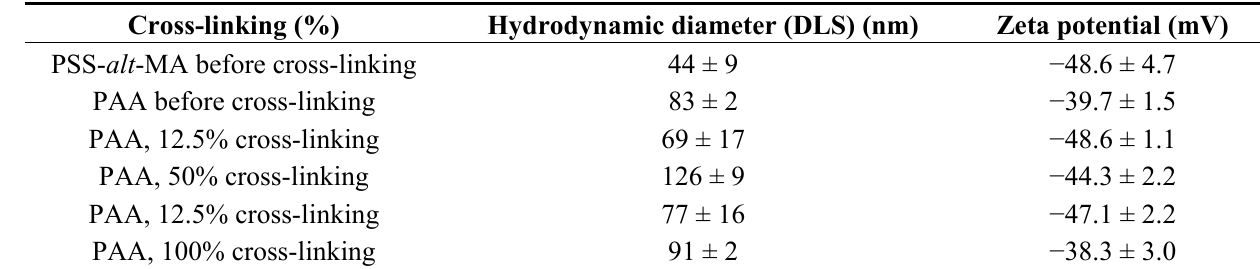
Table 3. Zeta potential and average hydrodynamic diameters of poly(acrylic acid) (PAA) or poly(styrene sulfonate- alt -maleic acid) (PSS- alt -MA)-coated IONPs with different cross-linking densities for an iron oxide concentration of 0.14 wt% at pH 8. Adapted with permission from [33]. Copyright 2011 American Chemical